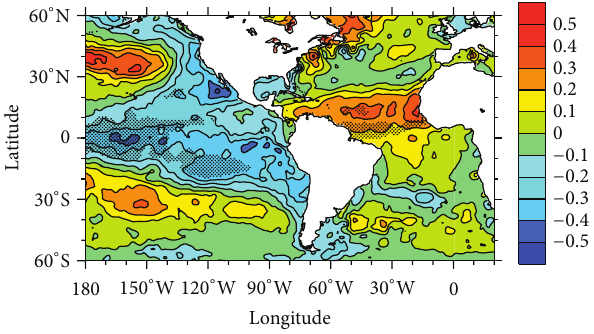
Figure 11: Annual mean sea surface temperature (K) anomaly for HCSA strong cases in the period 1996–2011 based on the HADISST dataset. Contour intervals are 0.1K with stippling indicating regions statisticallysignificantabovethe95%confidencelevelasdetermined by two-tailed Student’s 𝑡 -test.